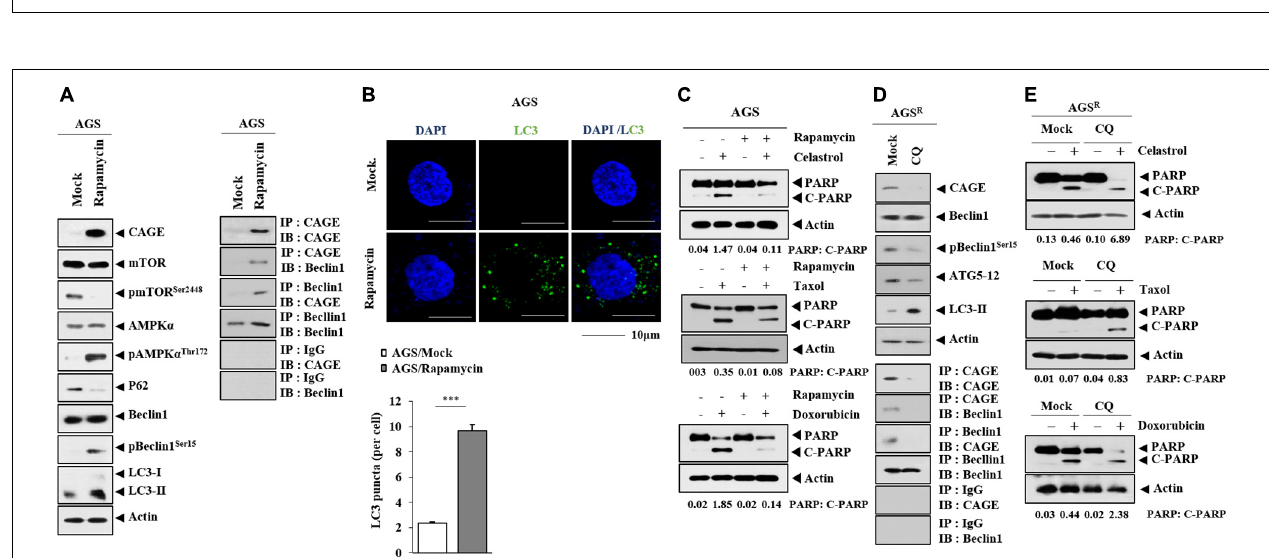
FIGURE 3 | CAGE expression is regulated by autophagy regulators. (A) AGS cells were treated with or without rapamycin for 24 h. Representative blots of three independent experiments are shown. (B) AGS cells were treated with or without rapamycin for 24 h, followed by immunofluorescence staining. ***, p < 0.001. (C) AGS cells were treated with or without rapamycin (5 µ M) for 24 h, followed by treatment with celastrol (1 µ M), Taxol (1 µ M), or doxorubicin (1 µ M) for 24 h. Representative blots of three independent experiments are shown. (D) AGS R cells were treated with or without chloroquine (CQ) (100 µ M) for 24 h. Representative blots of three independent experiments are shown. (E) AGS R cells were treated with or without CQ (100 µ M) for 24 h, followed by treatment with the indicated anticancer drug for 24 h. Representative blots of three independent experiments are shown.